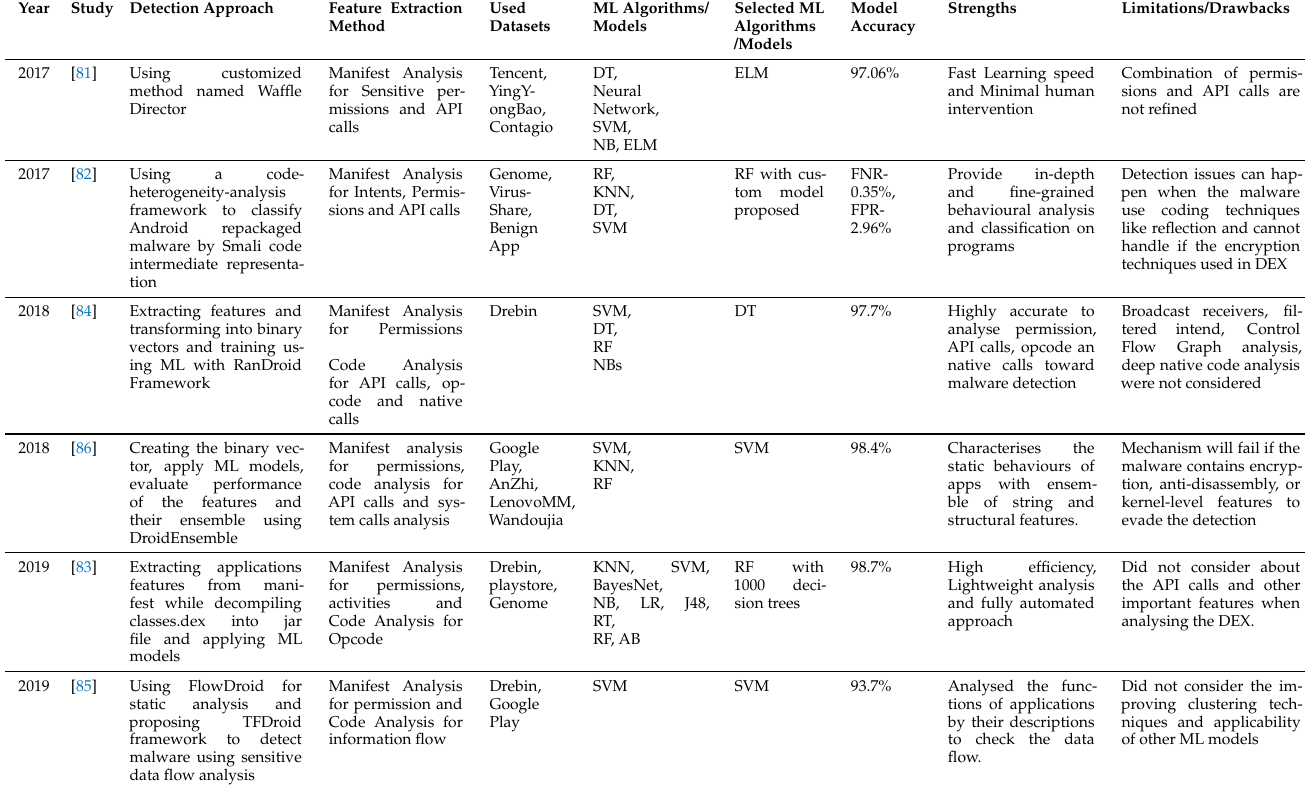
Table 4. Both Manifest and Code based Static Analysis with